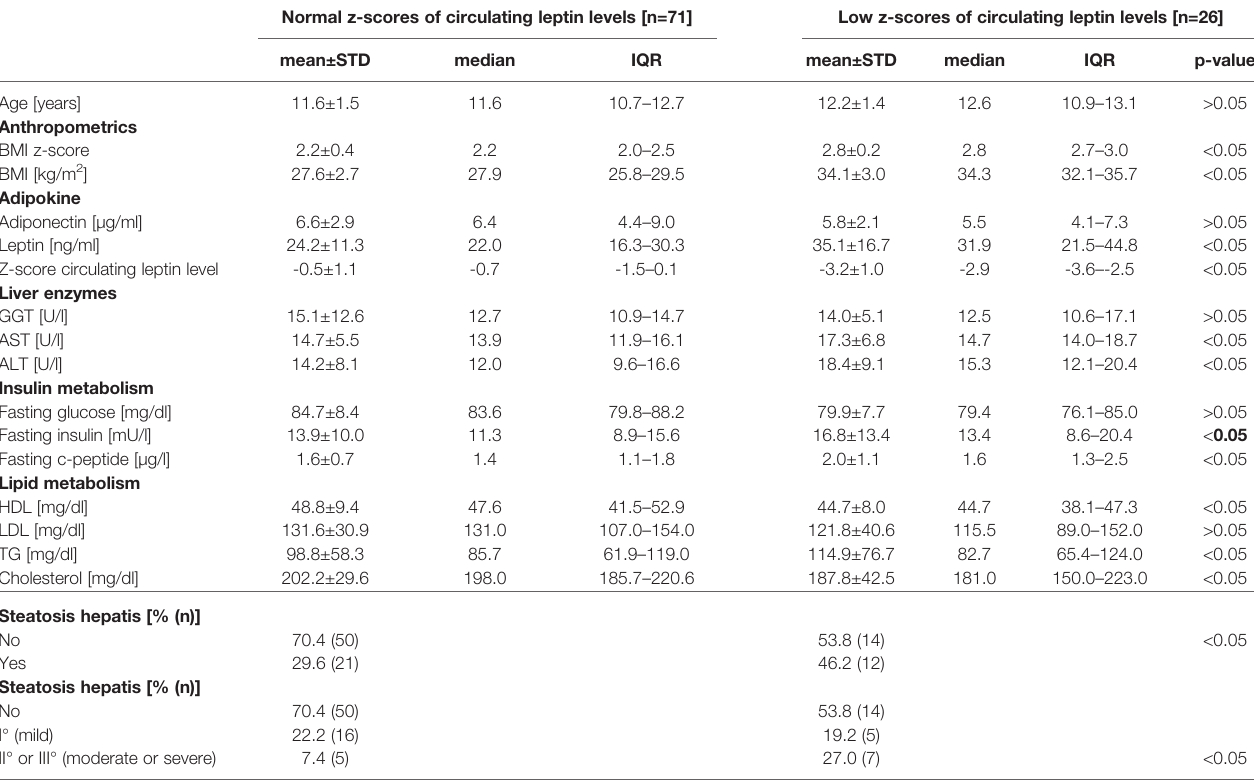
TABLE 2 | Comparison of anthropometric and metabolic parameters (adipokine, liver enzymes, insulin and lipid metabolism) as well as of the percentage of pre- pubertal children with obesity and with diagnosed steatosis hepatis between the group of children with normal z-scores of circulating leptin levels (n=71) and the group of children with low z-scores of circulating leptin levels